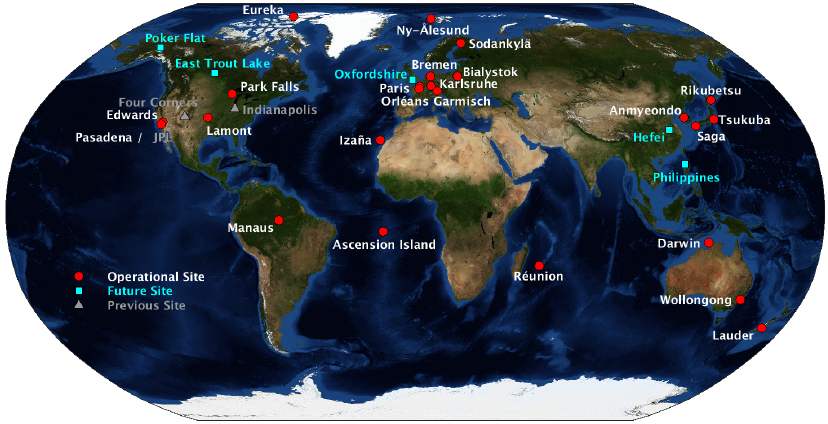
Figure 2. Ground-based stations of the Total Carbon Column Observing Network (TCCON). From the TCCON data archive homepage [34]. Credits for the underlying image: Blue Marble: Next Generation, produced by Reto Stöckli, NASA Earth Observatory (NASA Goddard Space Flight Center). Table 1. List of the TCCON stations included in the nominal (this paper) or extended (Supplementary Material) comparisons. Their geographic location, status of operations and reference for the dataset are given. Sites are arranged by decreasing latitude from north to south. The data description and site information can be found on the TCCON website [35].